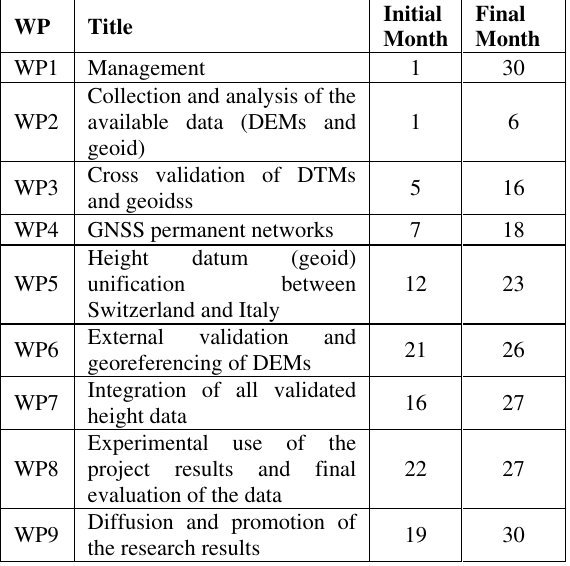
Table 1. Work Packages of the HELI-DEM